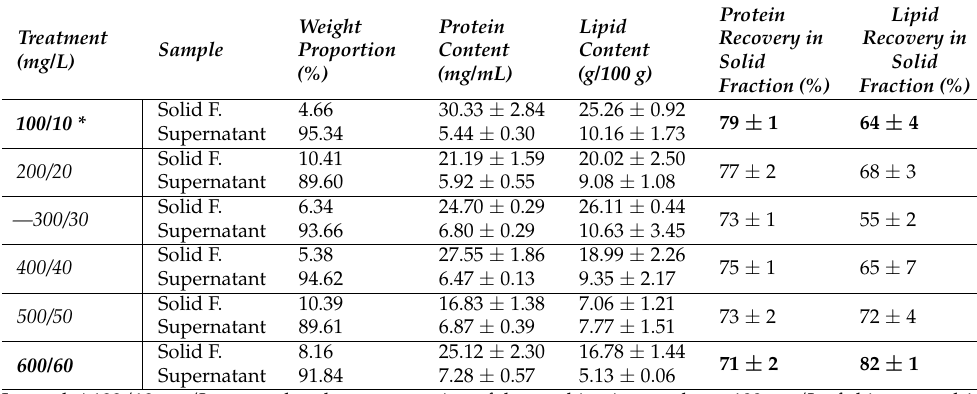
Table 4. Protein and lipid recovery obtained by coagulation/flocculation using different Chi- tosan/Carrageenan combinations. Analytical data are shown as mean ± SD (n = 3). Treatment